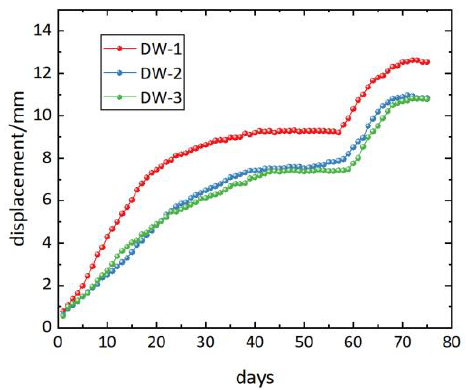
Figure 8. Field monitoring data curve of displacement measuring point.